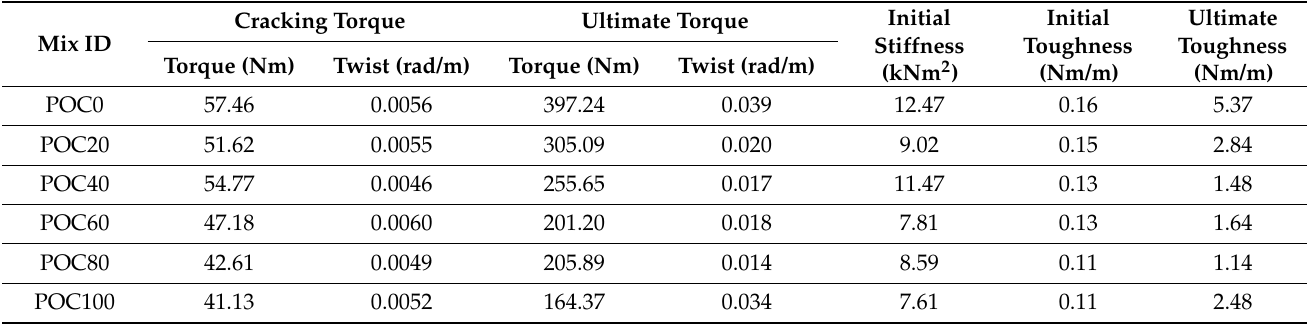
Table 3. Torsional behavior of concrete at different replacement level of POC.